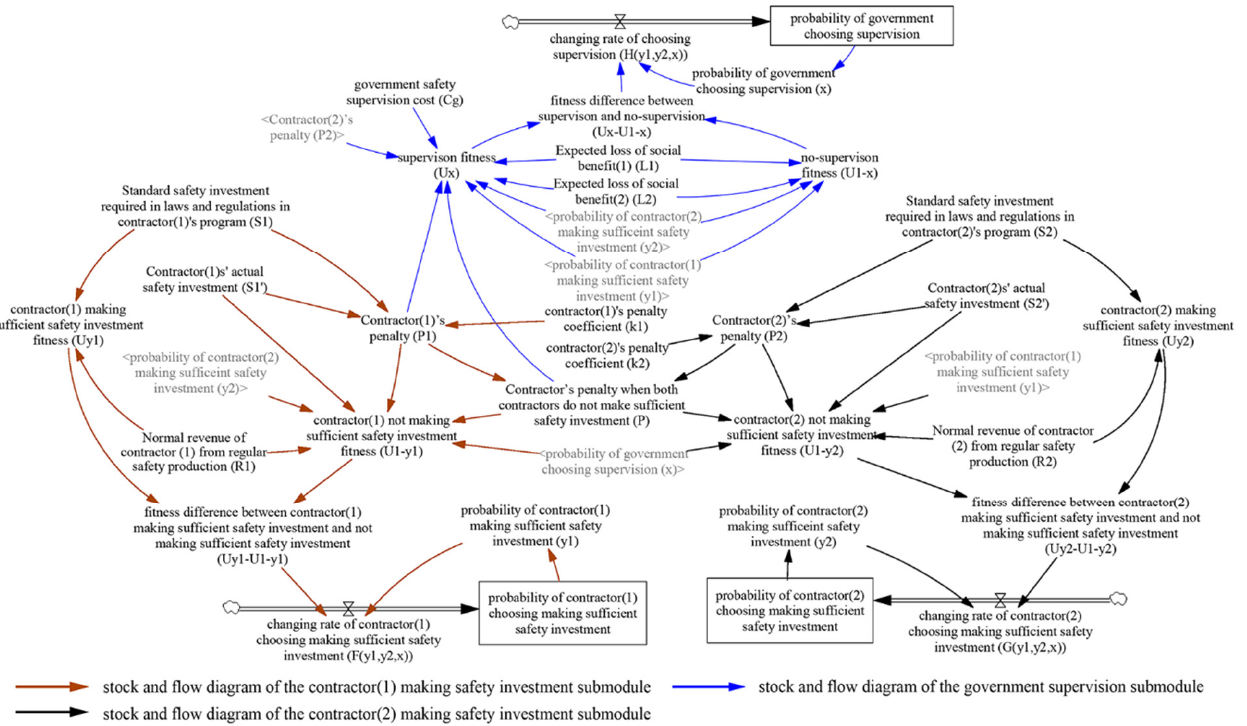
Figure 6. The stock and flow diagrams of evolutionary game SD model under static penalty control strategy.